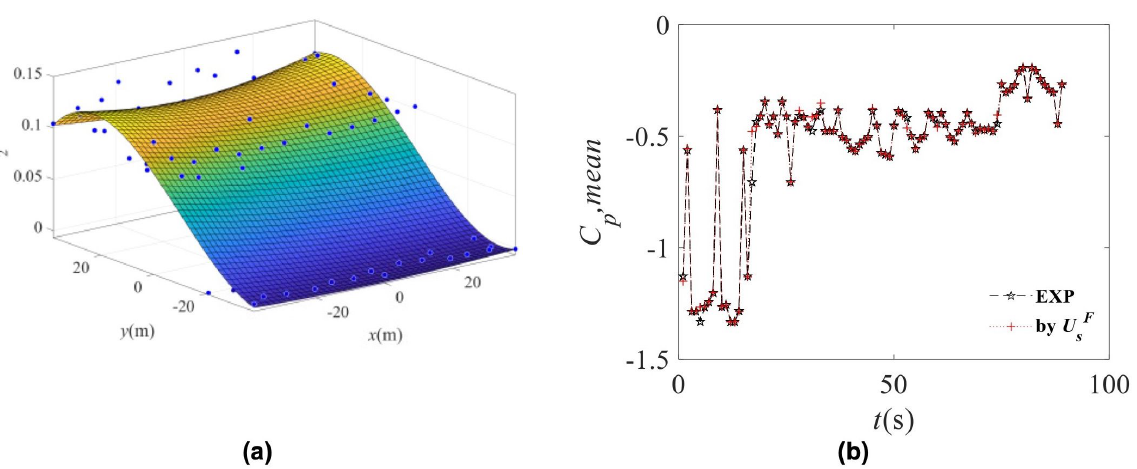
Figure 17: Example of spatial variation of coeflcient x 1 , Eq. (2), for the case G 1 , θ = 0 ∘ (a) and comparison between C p , mean by experiments and by U SF